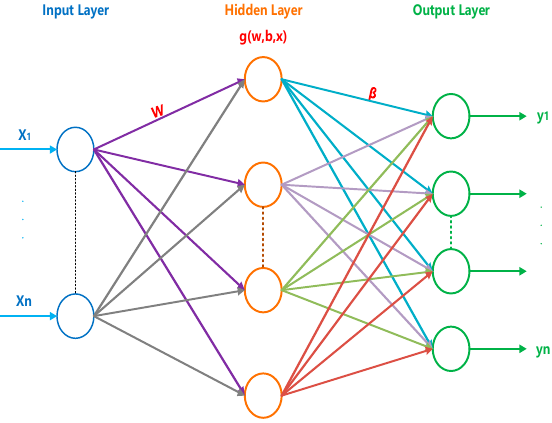
Figure 6. Schematic diagram of the single hidden layer feed forward neural network (SLFN) structure.